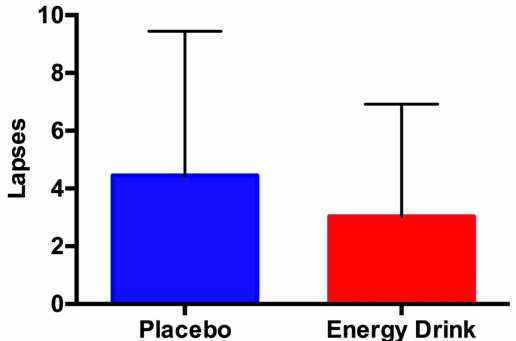
Figure 3. Lapses. Data are shown as the mean ± SD. A lapse is defined as a reaction time > 500 milliseconds. The energy drink treatment also had fewer lapses during the PVT ( p =